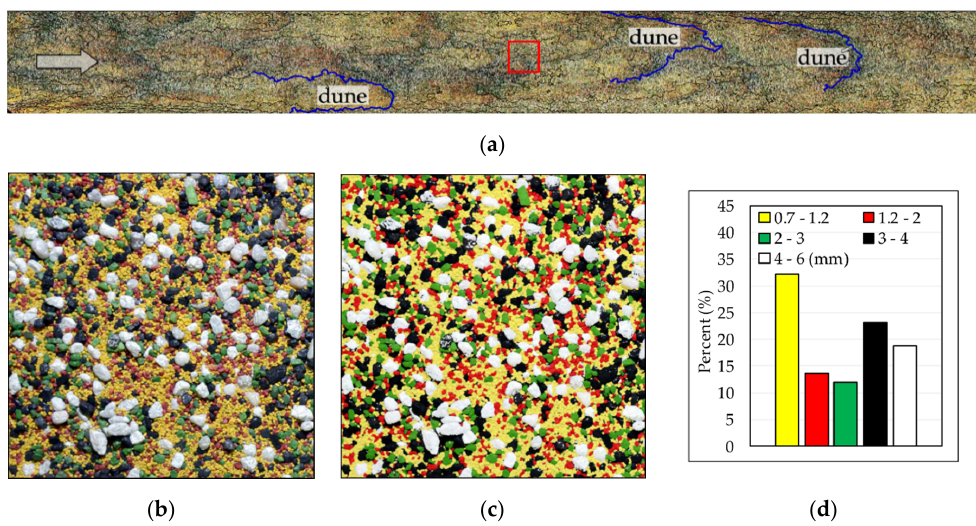
Figure 4. ( a ) Compound orthophoto of the bed surface material of the experimental section. The arrow indicates the flow direction. The red square indicates the location of the 0.12 × 0.12 m section detail; ( b ) red square detail of the orthophoto; ( c ) red square detail of the processed orthophoto which is reduced to five different colors only, each pixel belongs to one and only one color class; ( d ) grain size distribution of the red square detail.